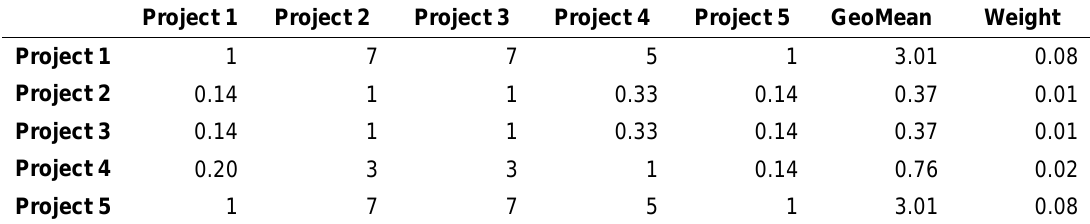
Table 5. Comparison of projects using AHP .